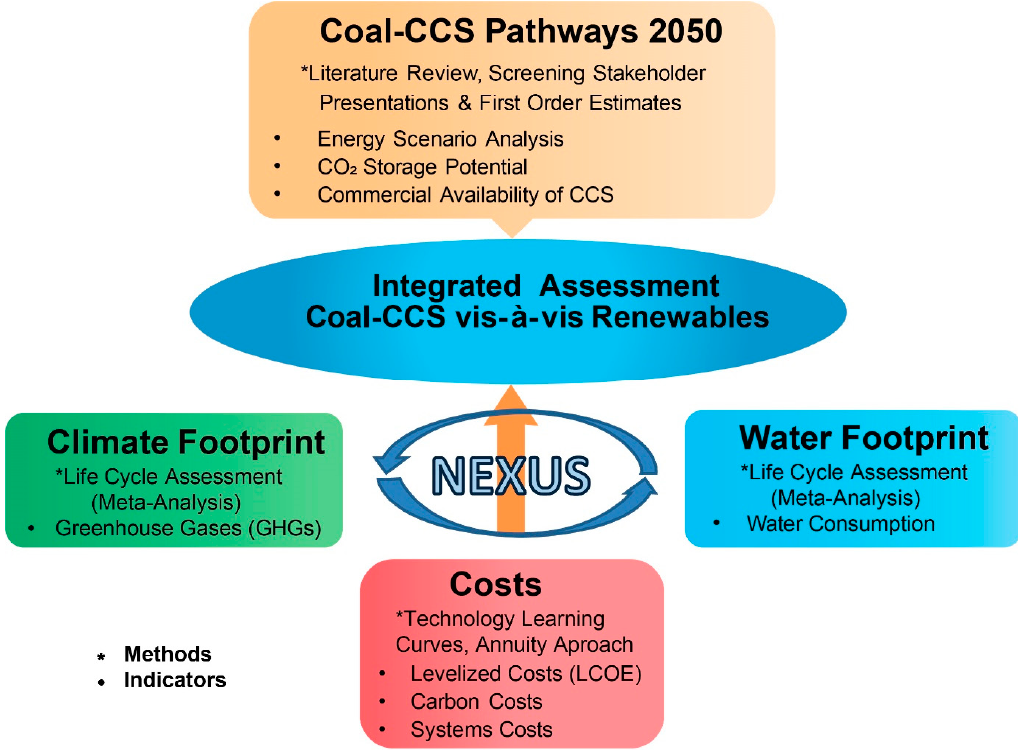
Figure 1. Integrated assessment methodology encompassing multiple energy sustainability assessment dimensions, including the methods and indicators used in this study.